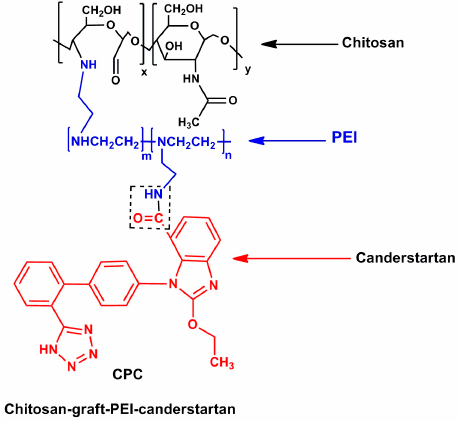
Figure 4. The molecular structure of the Chitosan-graft-PEI-candesartan polymer used in targeting pancreatic cancer cells [66]. (Source: Bao et al., 2014). pancreatic cancer cells [66]. (Source: Bao et al.,